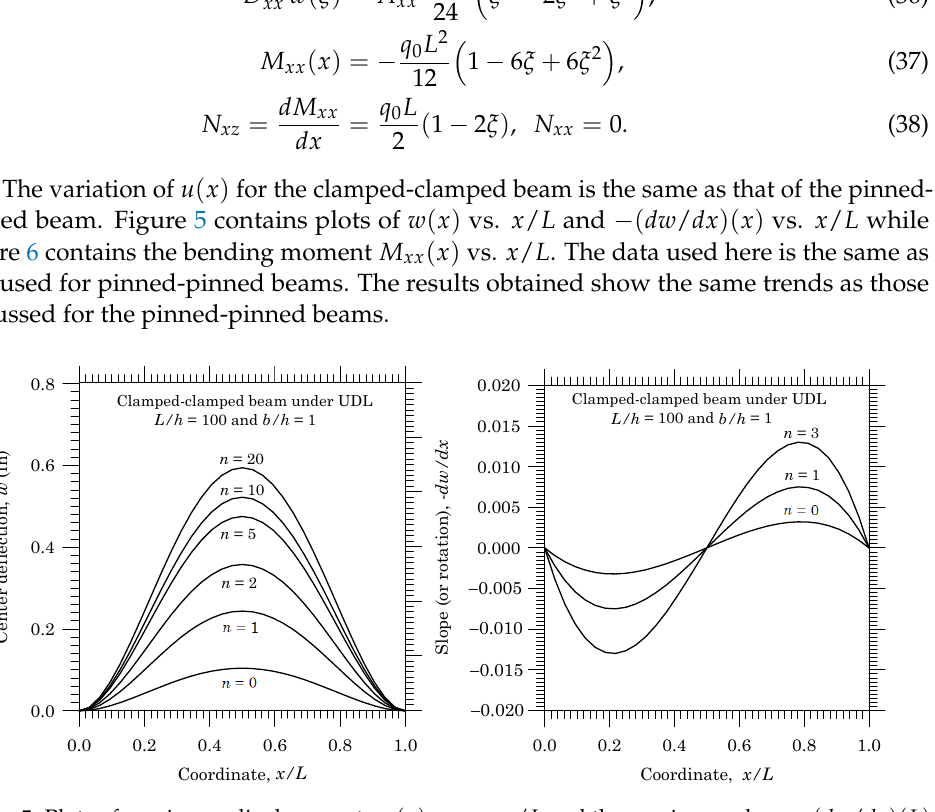
Figure 5. Plots of maximum displacements w ( x ) versus x / L and the maximum slope − ( dw / dx )( L ) versus x / L for clamped-clamped FGM beams under uniformly distributed transverse load.